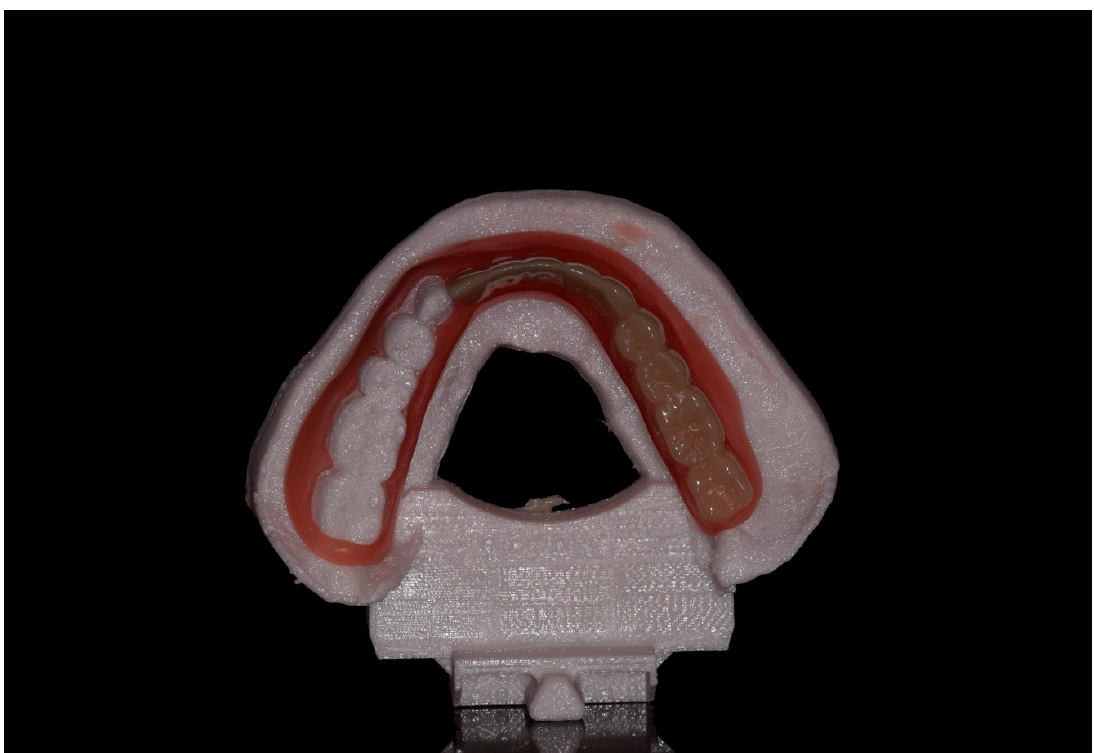
Figure 7. 3D printed polyamide (Valplast) removable partial denture. The prosthesis lacks rest seats and clasp assemblies and relies on engaging retentive undercuts of the remaining teeth.